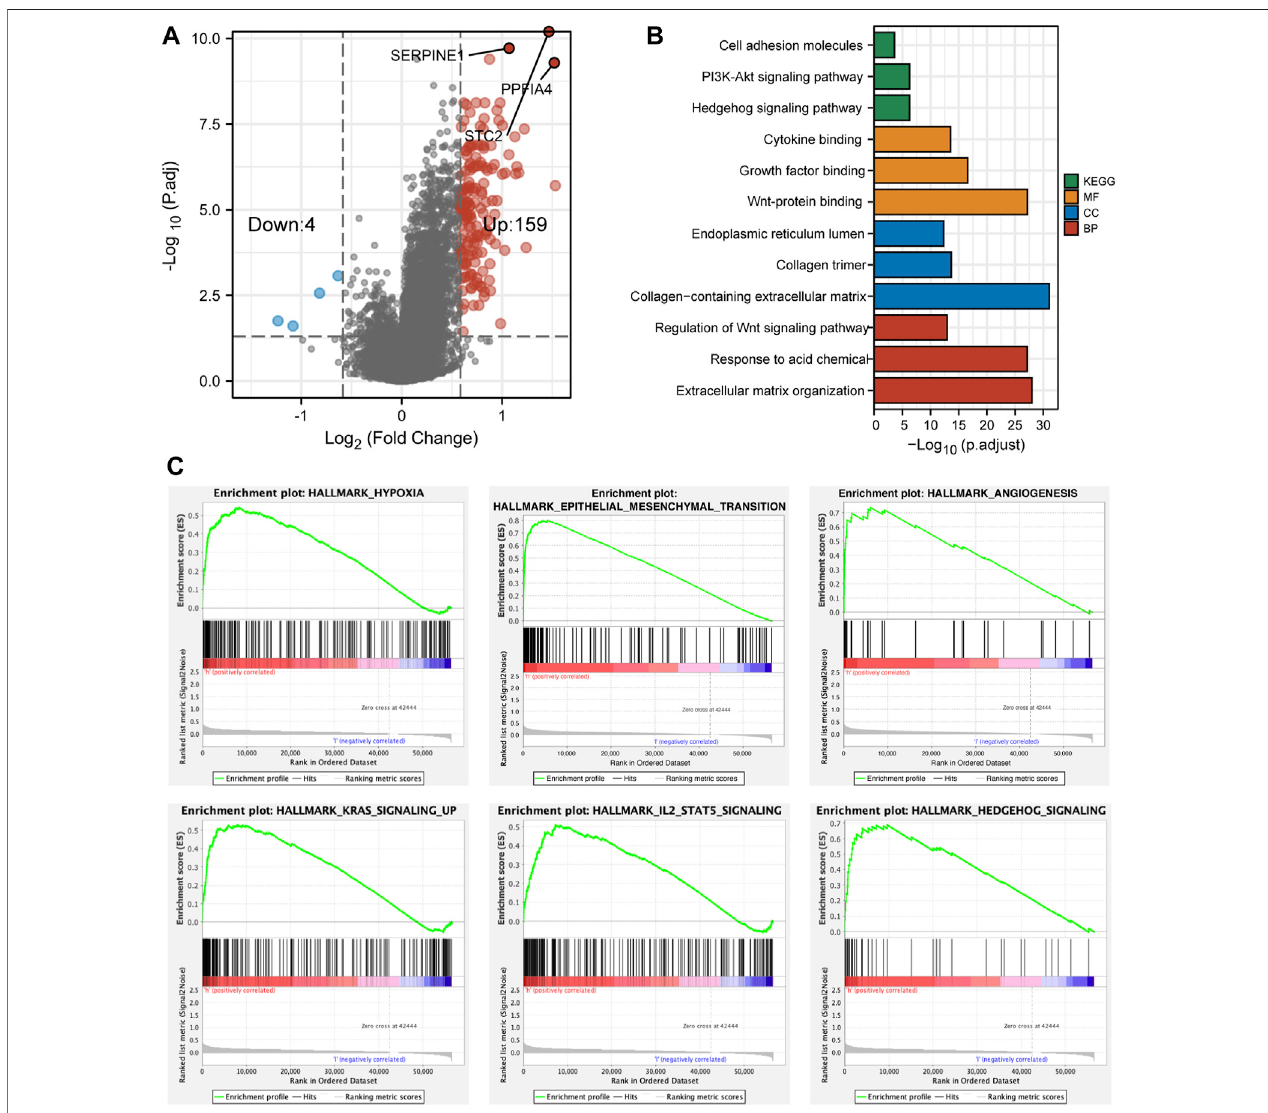
FIGURE 6 | The differentially expressed genes and functional enrichment. (A) The volcano plot showed that 159 genes were highly expressed and 4 genes were lowly expressed in HS. (B) The bar plot revealed different functional enrichment involved in HS, according to the DEGs. (C) The results of GSEA analyses showed that hypoxia, EMT, angiogenesis, KRAS, IL2, and hedgehog pathways were enriched in HS.